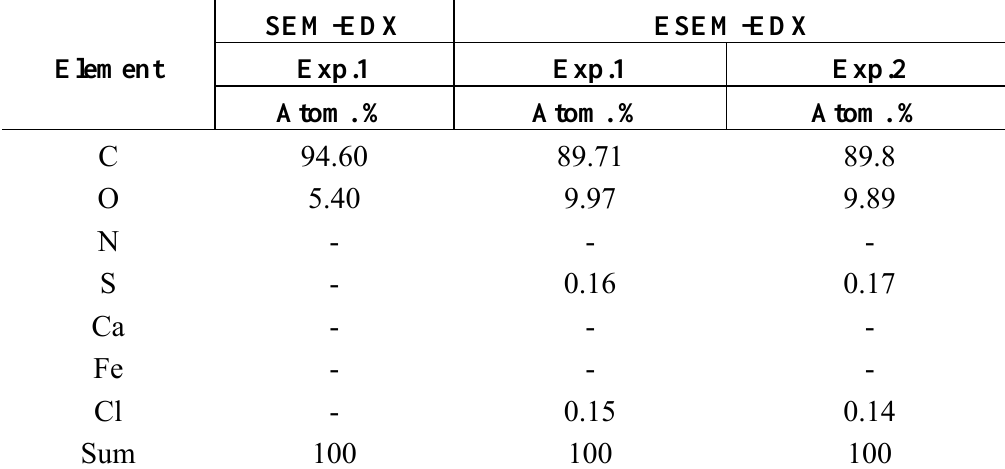
Table 1. EDX results on the elemental composition of the SCN